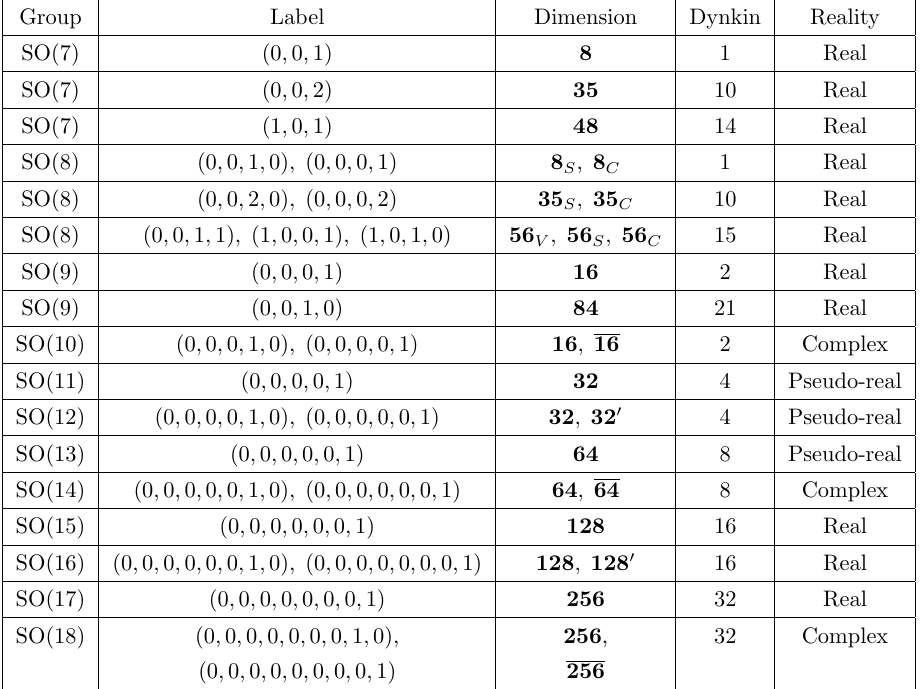
Table 19 . Various group theory date for SO( N ) representations associated with spinors and tensors with more than two indices. Here the group entry stands for the group in question, and the label entry stands for the standard Dynkin label of the representation. Additionally, the dimension, Dynkin index and the reality properties of the representation are listed.